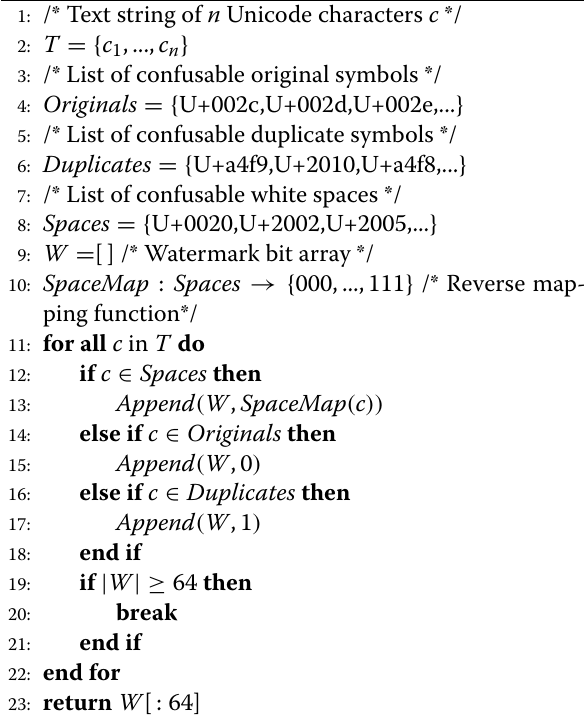
Algorithm 2 W ATERMARK E